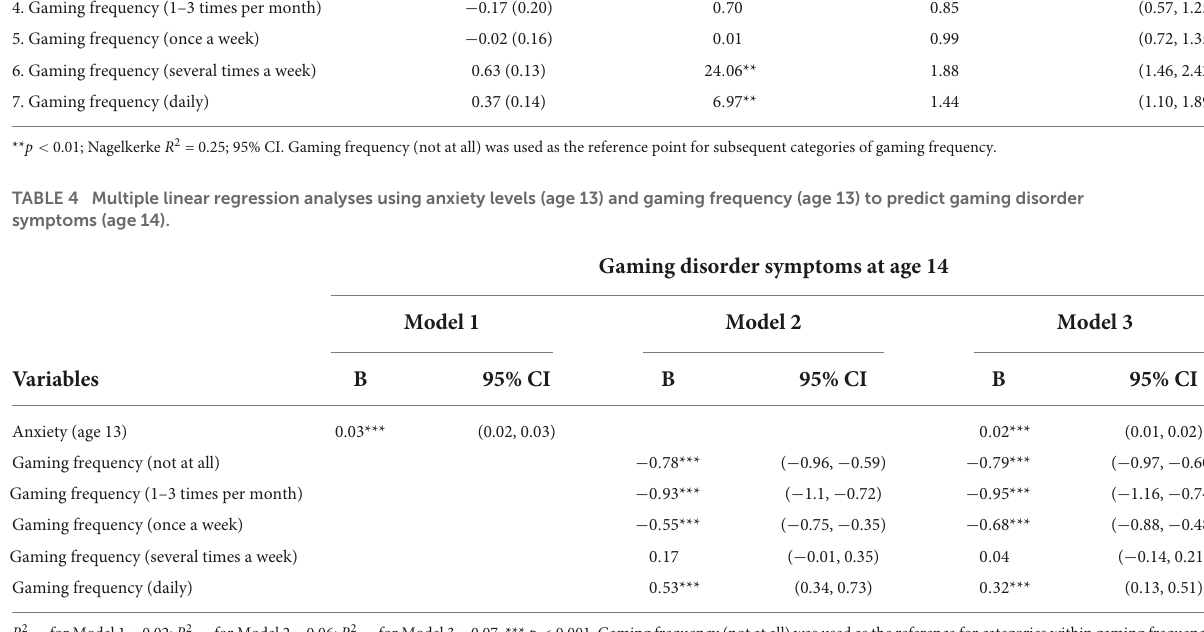
TABLE 5 Linear regression analysis using gaming disorder symptoms (age 13) to predict anxiety levels 12 months later (age